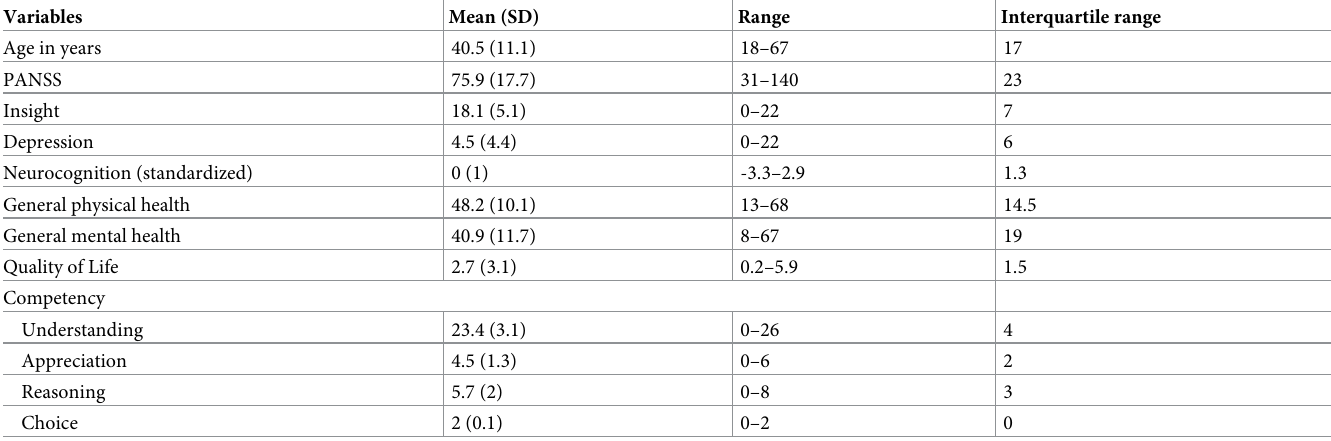
Table 1. Descriptive summary of variables at